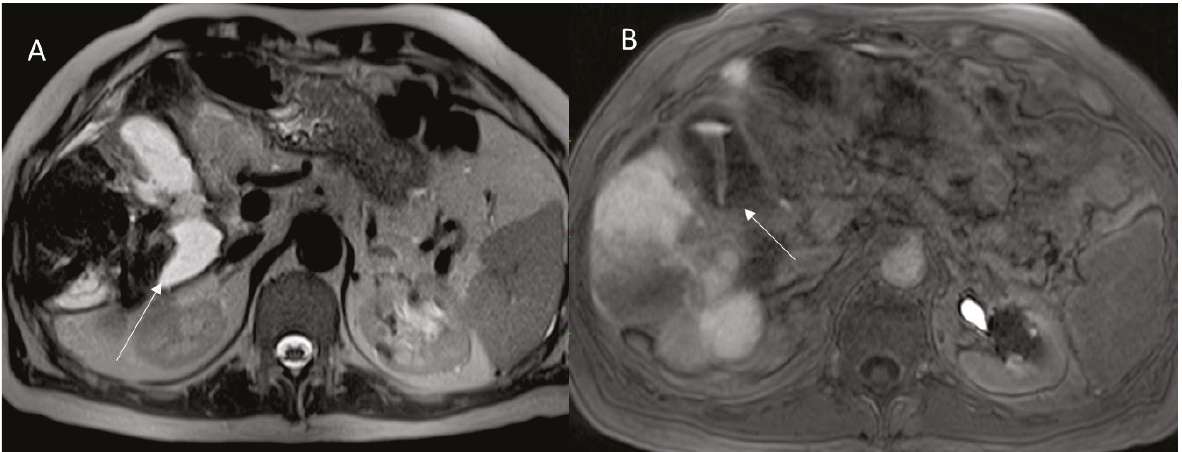
Figure 4. Man 74 year at 1-month follow-up after RFA of HCC on VI seg. MRI (( A ): HASTE T2-W sequences in axial, in ( B ): EOB-phase of contrast study in axial plane). The arrow shows bile leak.